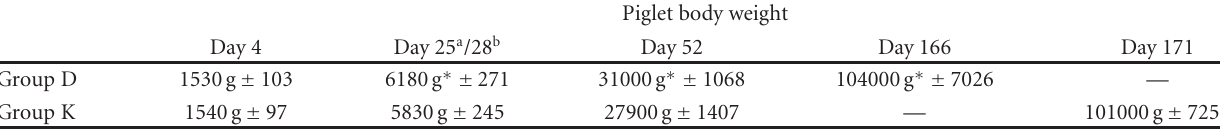
Table 2: Experiment 2: Mean piglet body